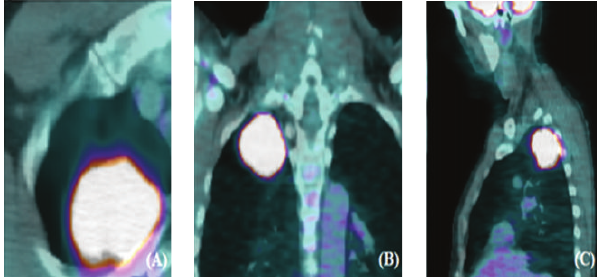
Figure 2: In PET-CT a high 18F-fluorodeoxyiglucose uptake con- firms the neoplastic nature of a superior sulcus lesion. CT also allowsamorphologicalstudythankstothepossibilityofmultiplanar reformations on the axial (A), coronal (B), and sagittal planes (C).